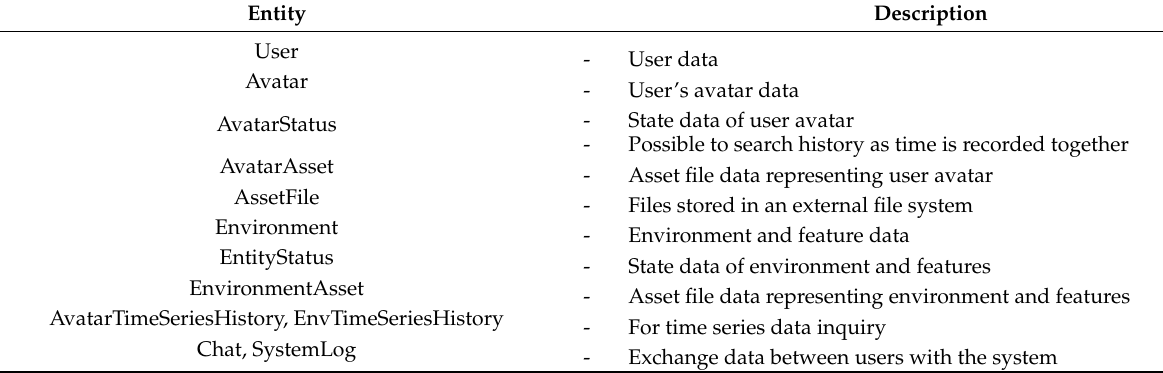
Figure 6. Expression data model.